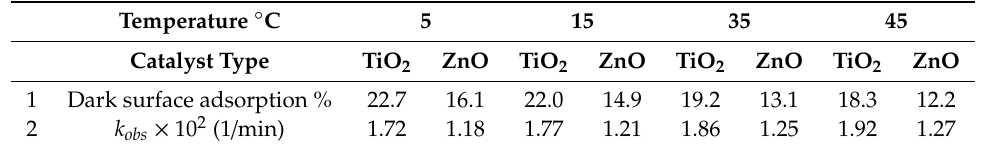
Table 3. Effects of temperature on photocatalytic decolorization and mineralization rate as well as dark surface adsorption of FB1; [FB1] 0 = 50 mg/L, [TiO 2 ] = 0.8 g/L, [ZnO] = 1.2 g/L and pH = 6.7.